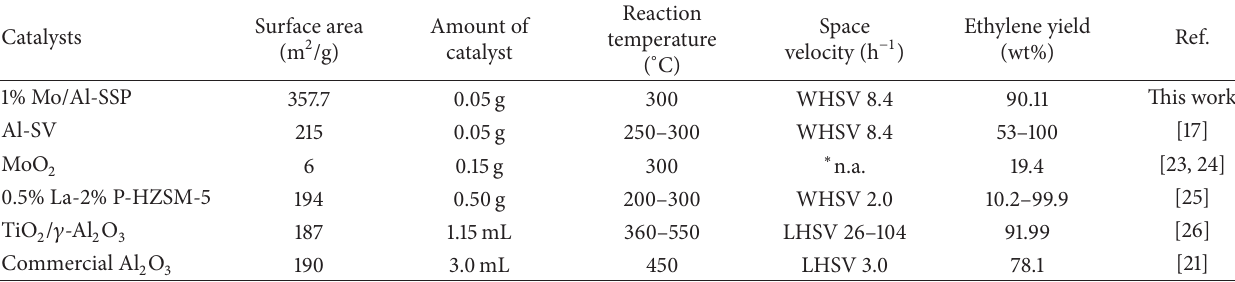
Table 5: A comparison of catalysts for ethylene synthesis and their catalytic